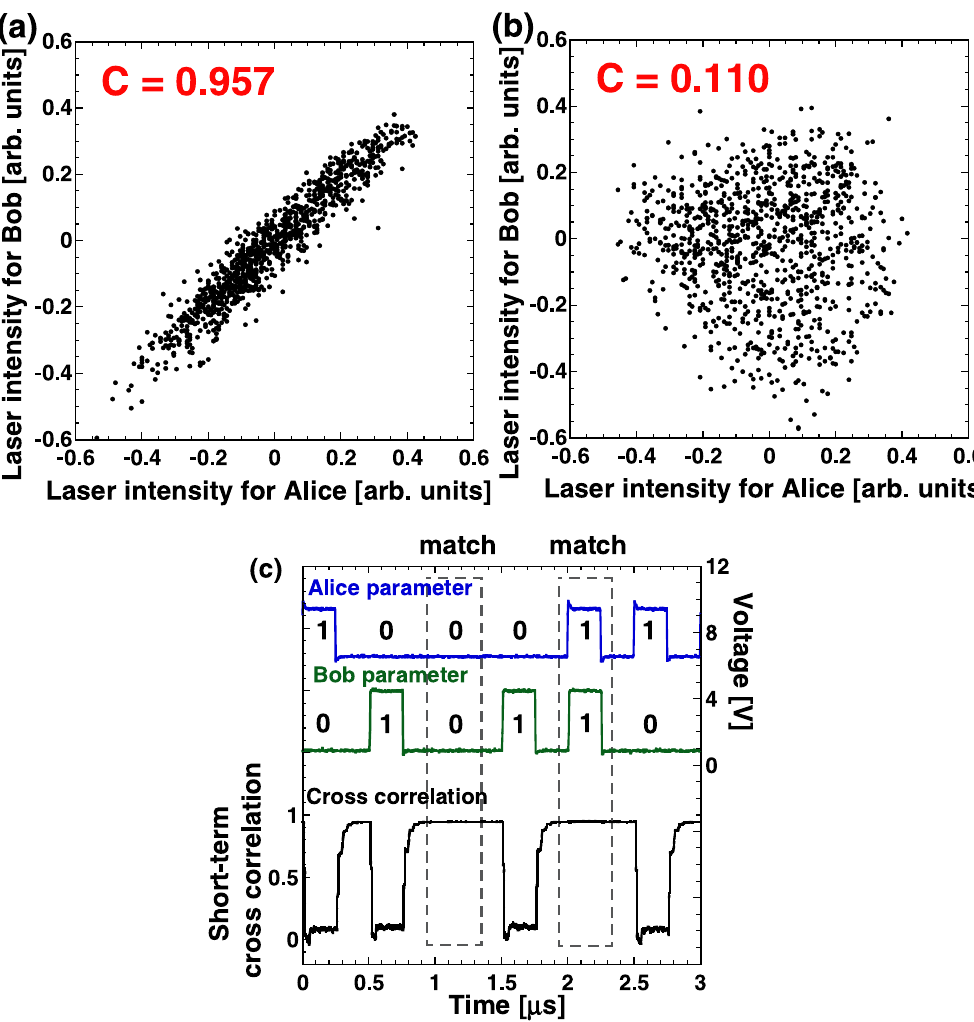
Figure 3. Experimental result of optical correlated randomness. ( a , b ) Correlation plots of temporal waveforms of Alice’s and Bob’s laser outputs. C indicates cross-correlation value. ( a ) Same parameter selection, and ( b ) different parameter selection. ( c ) Example of parameter switching. Alice’s and Bob’s parameter values and the short-term cross-correlation between Alice’s and Bob’s temporal waveforms are